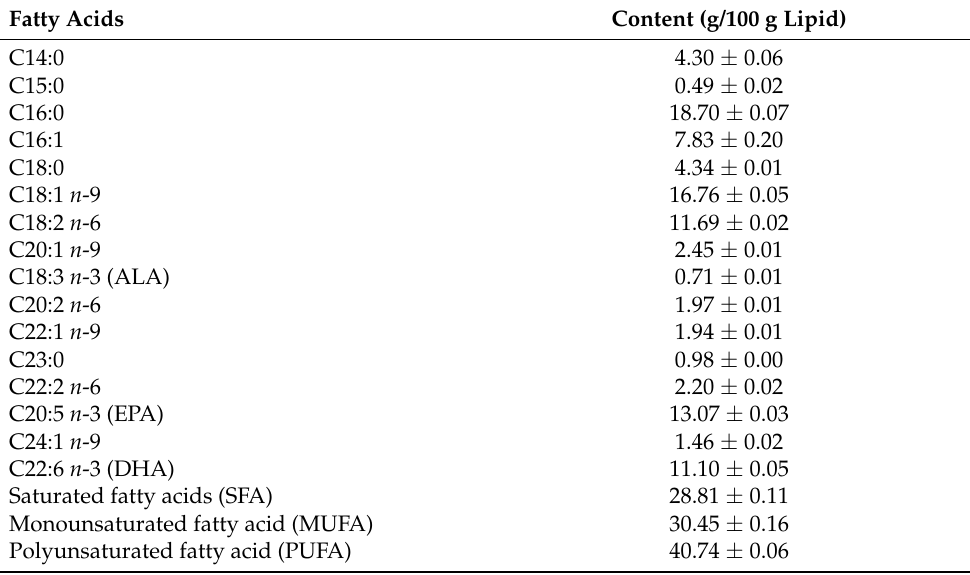
Table 1. Fatty acid composition of lipid extracted from hydrolyzed collagen without fat